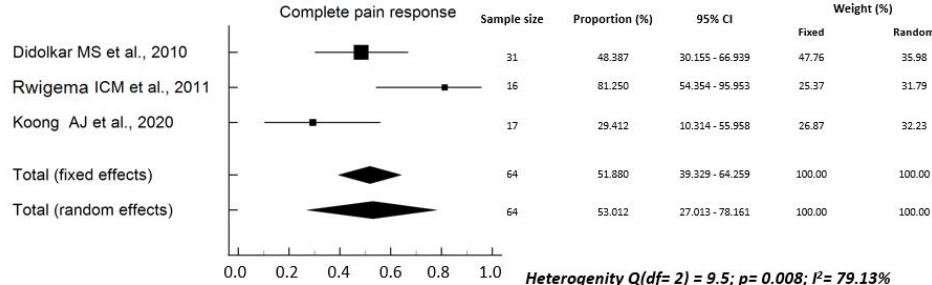
Figure 2. Overall rate of reduction or suspension of analgesic therapy [17,22,24,26,28,34].